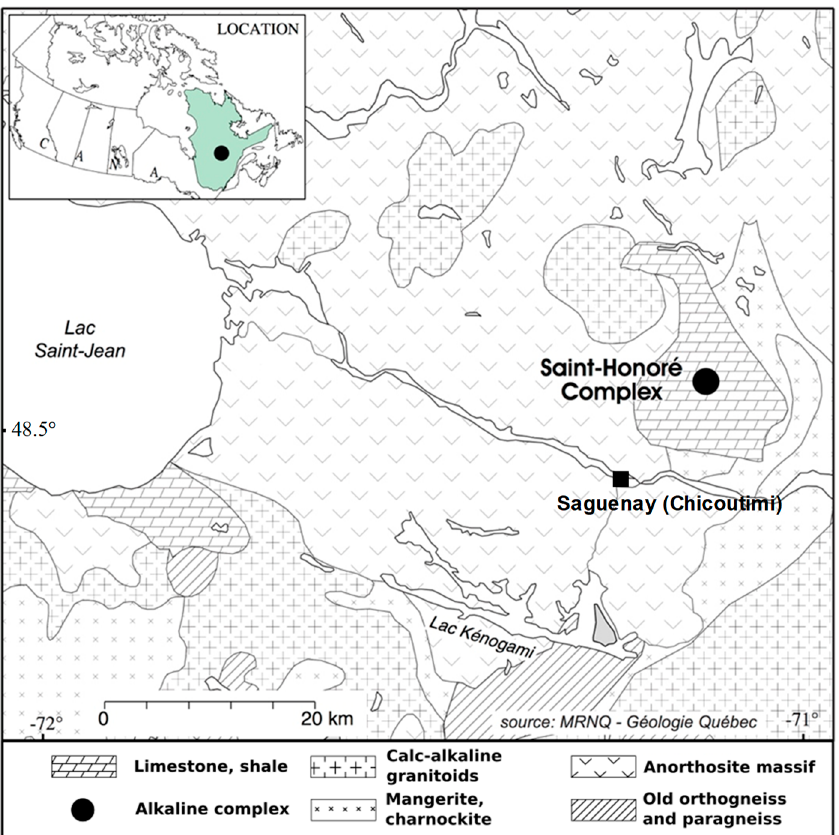
Figure 1. Study site location and local geology of the Saint-Honoré alkaline complex. Map modified from [39]. Note that the Saint-Honoré Complex is covered by the limestone and its location is interpreted from diamond drill hole surveys.